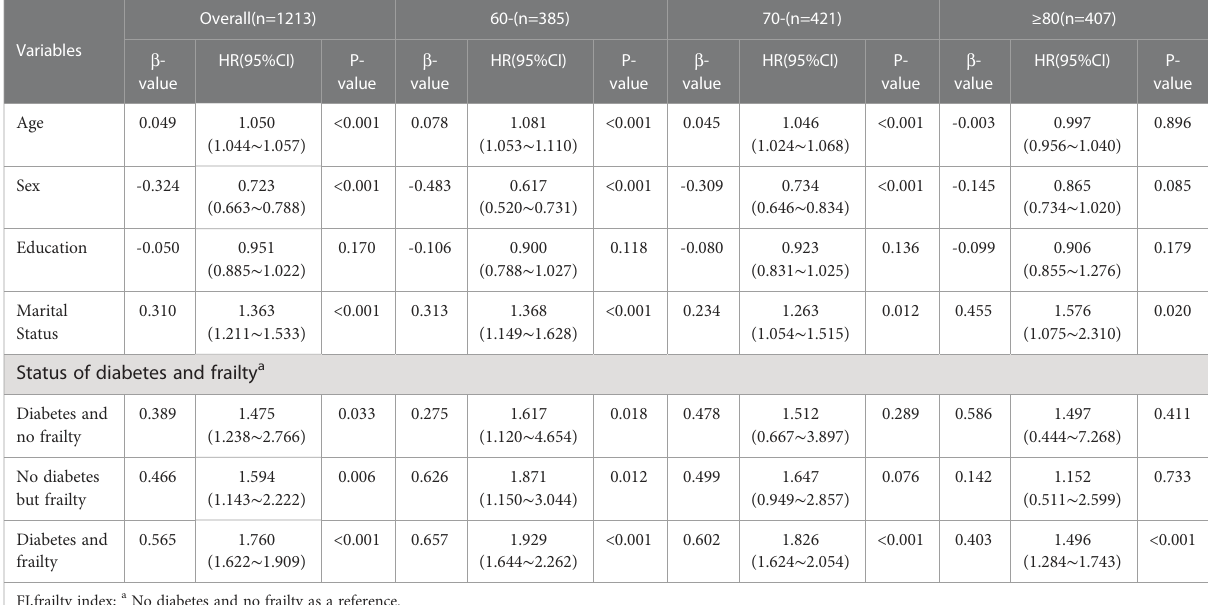
TABLE 2 Multivariate Cox regression analysis of the impact of diabetes and frailty on mortality in the older adults of different